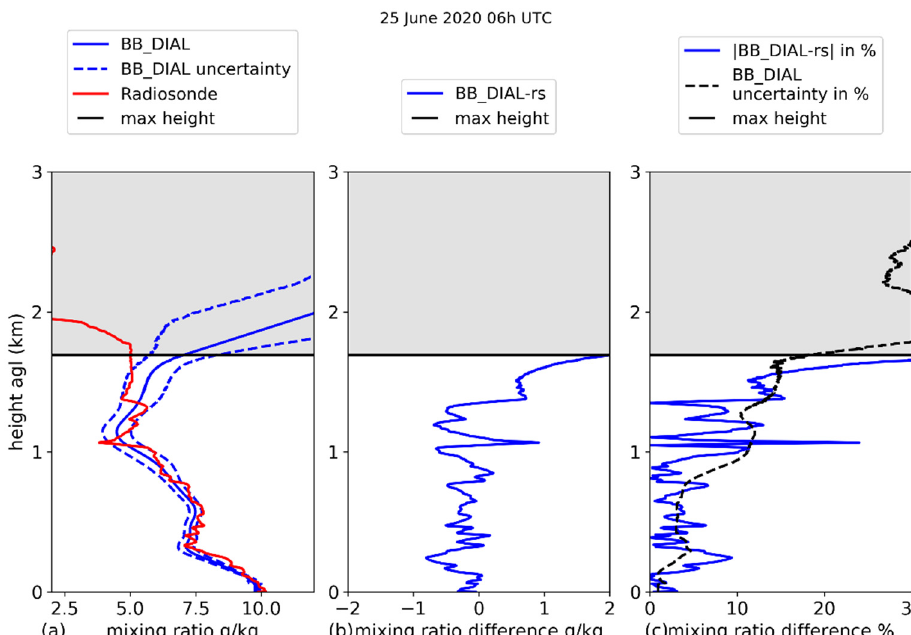
Figure 6. ( a ) Example of BB-DIAL (blue) and radiosonde mixing ratio for the 25 June 2020 at 06 UTC, ( b ) is the difference between the BB-DIAL mixing ratio and the radiosonde mixing ratio, ( c ) in blue is the absolute difference (%) against radiosonde measurement, black dash-line is the BB-DIAL uncertainty in % against the BB-DIAL measurement. The horizontal black line is the maximum height trusted value.